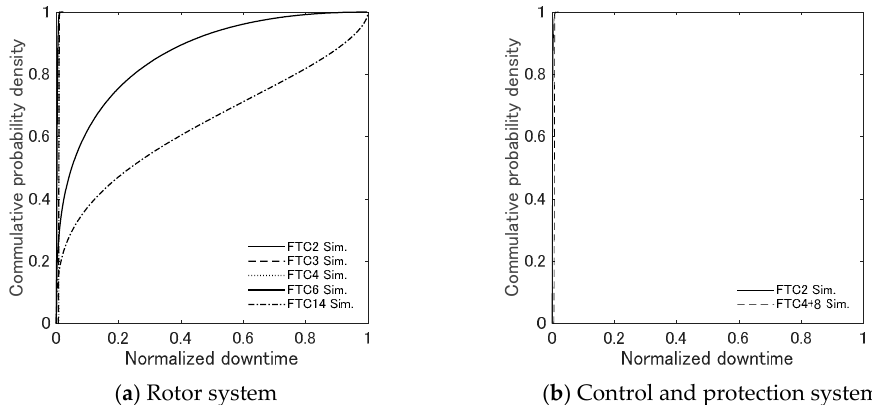
Figure 10. Cumulative distribution of downtime for Scenario 1.